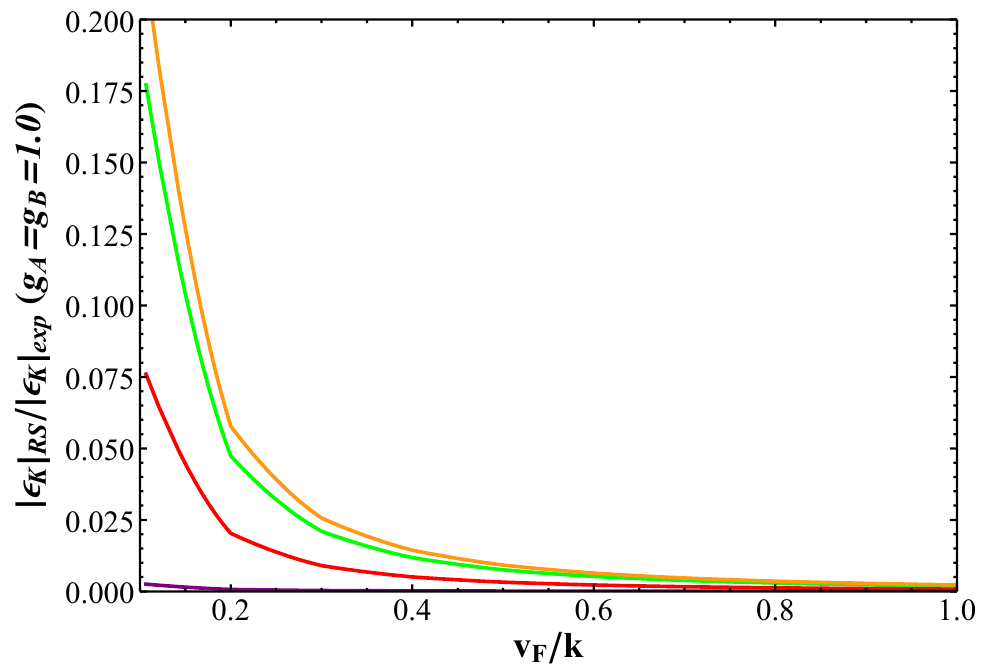
Figure 8. the contribution to j (cid:15) K j emerging from new physics in our model, compared to its experimental value (2 : 228 (cid:6) 0 : 011) (cid:2) 10 (cid:0) 3 . Di(cid:11)erent colors represent di(cid:11)erent sample points in parameter